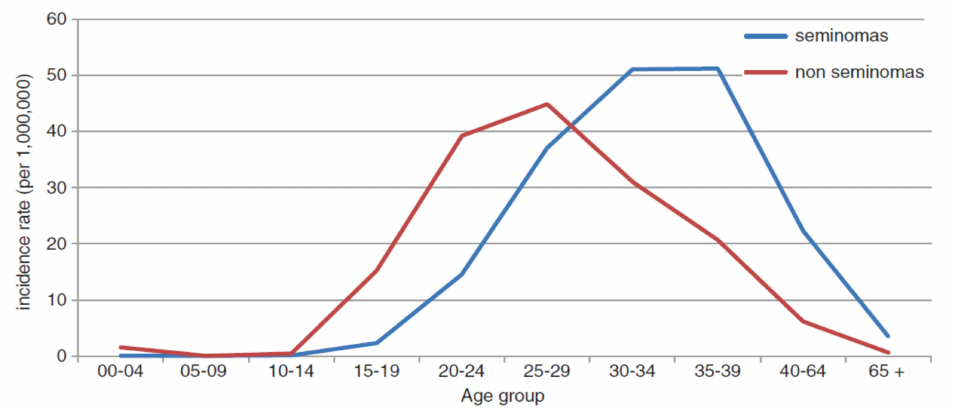
Figure 1. Graph depicting TGCT incidence per 1,000,000 by age group and histology using data from the EUROCARE study, published in 2017 by Annalisa Trama and Franco Berrino